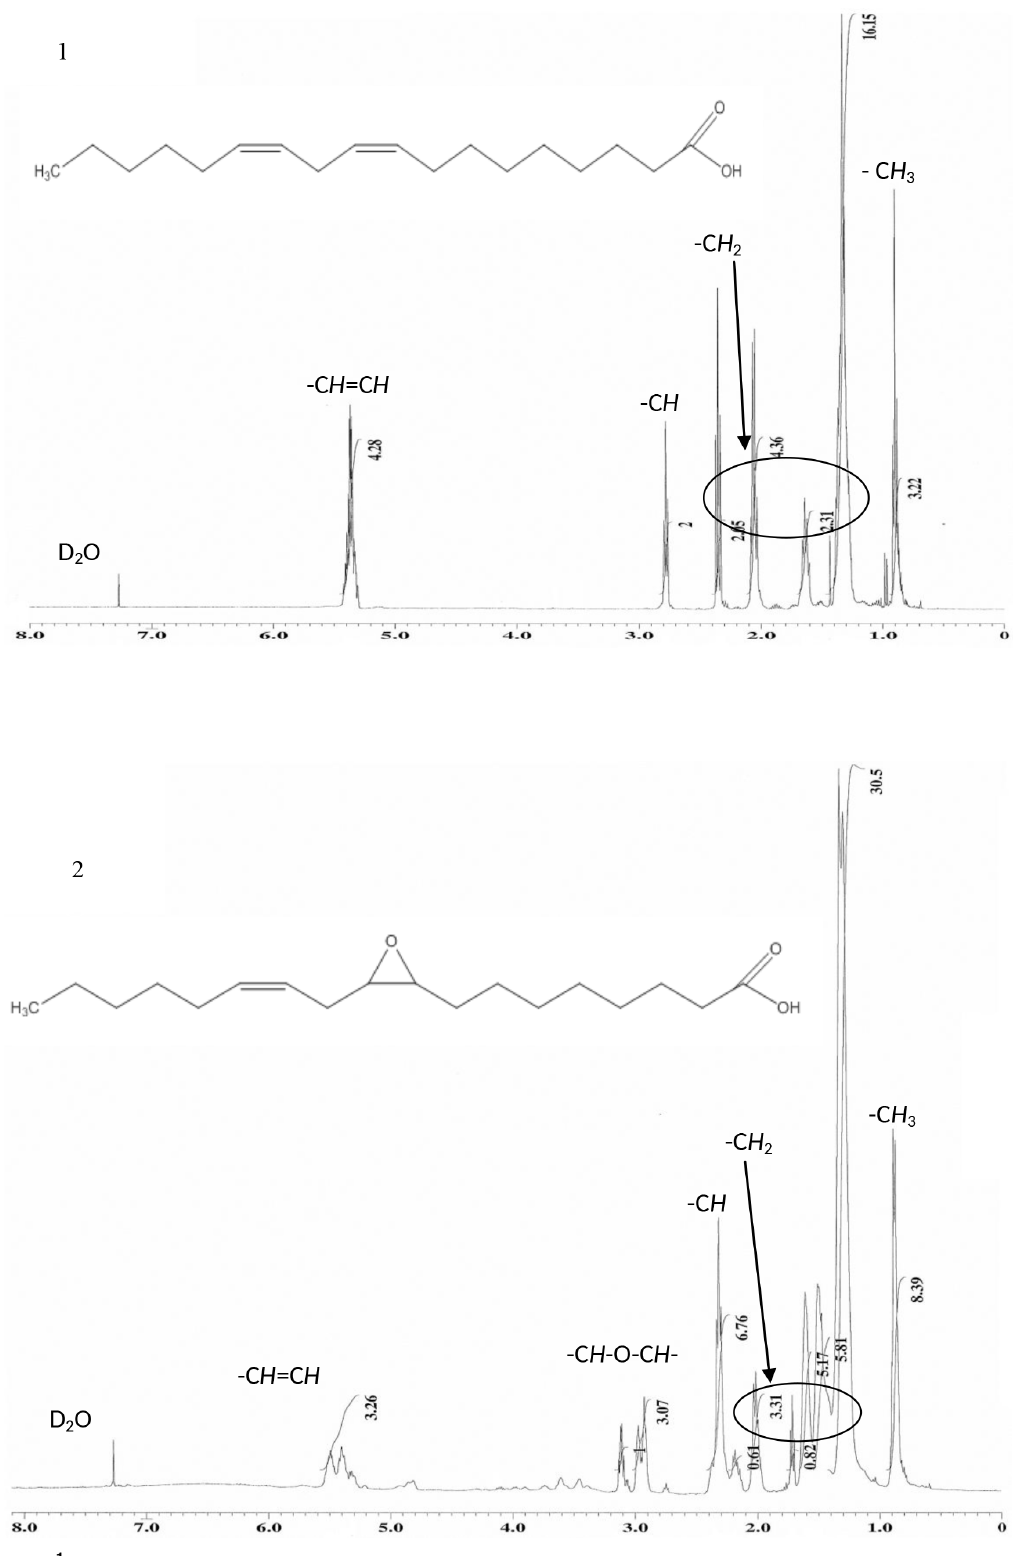
Fig 2. 1 H NMR spectrums of linoleic acid and synthesis compounds. (1) Linoelic acid. (2) Monoepoxidation. (3) Oxirane ring opening. (4) Esterification. (5) Acetlyation. doi:10.1371/journal.pone.0151603.g002 PLOS ONE | DOI:10.1371/journal.pone.0151603 March 23,